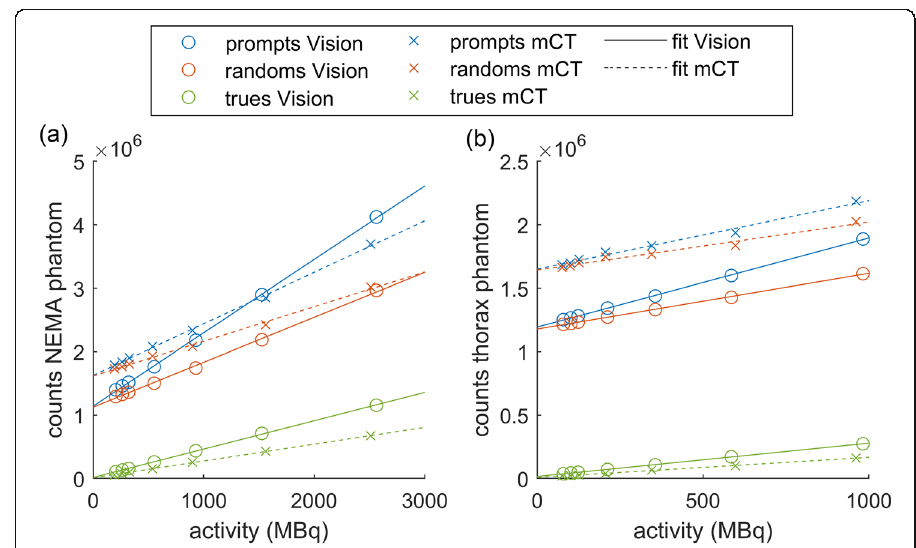
Fig. 1 Total prompts, randoms, and net trues for a range of 90 Y activities for the Vision and mCT acquisitions of the NEMA phantom ( a ) and the thorax phantom ( b ). The solid and dashed lines are linear fits of the data for the Vision and the mCT respectively